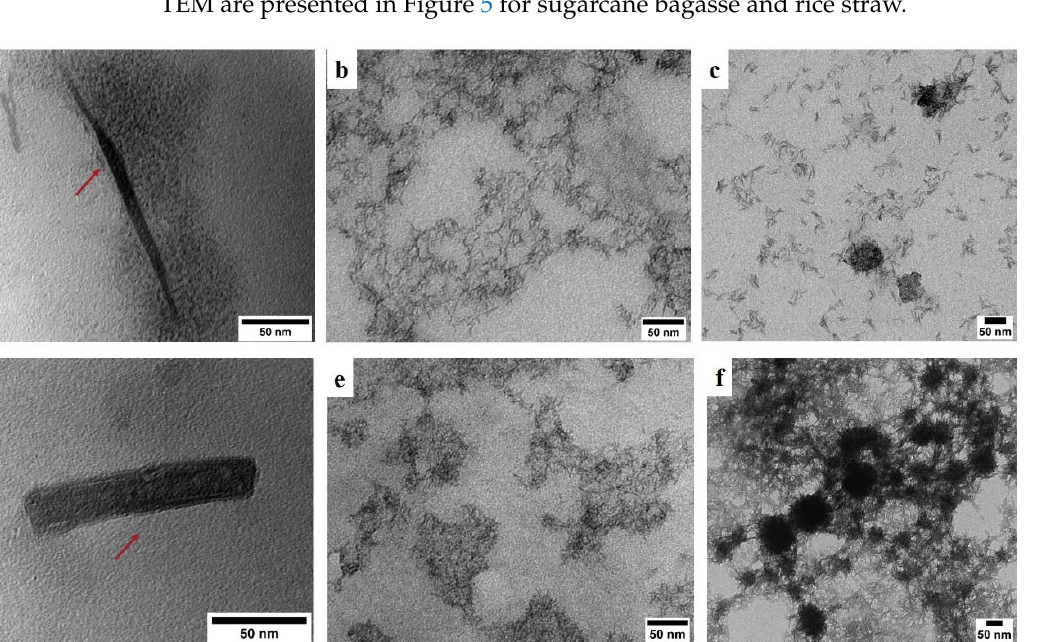
Figure 4. X ‐ ray diffraction patterns of CNC from (a) sugarcane bagasse (SB ‐ 20 A1) and (b) rice straw (RS ‐ 20 B1) after surface modification with various concentrations of CTAB. The last digit in the modified CNC sample code indicates a different CTAB concentration. 1 = 2 mM CTAB; 2 = 4 mM CTAB; 3 = 6 mM CTAB; 4 = 8 mM CTAB; and 5 = 10 mM CTAB.